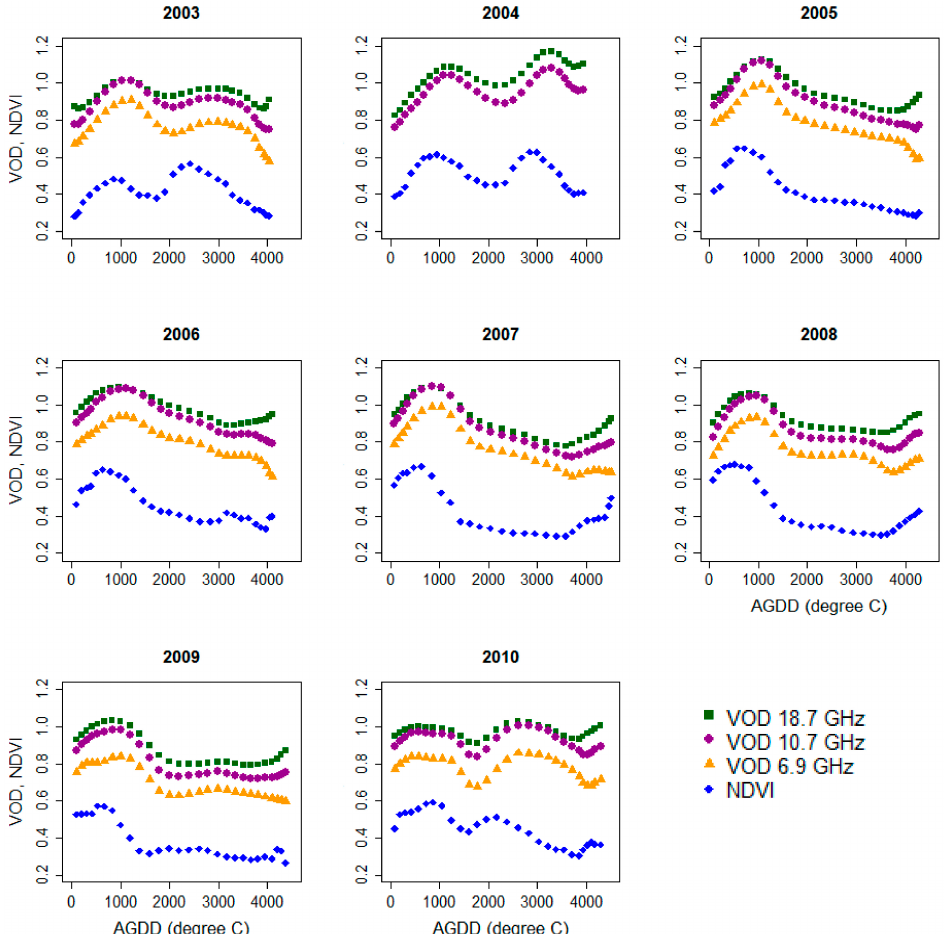
Figure 5. VODs in three microwave frequencies (green squares = 18.7, purple circles = 10.65, and orange triangles = 6.925 GHz) and NDVI (blue diamonds) interannual variability of a southern study site (Simferopol, UA, 45.6°N) for 2003–2010. The 6.925 GHz vegetation transmissivity was missing from the source dataset in 2004. Seasonal patterns changed from bimodal (2003–2004) to unimodal (2005–2009) and back to bimodal (2010).